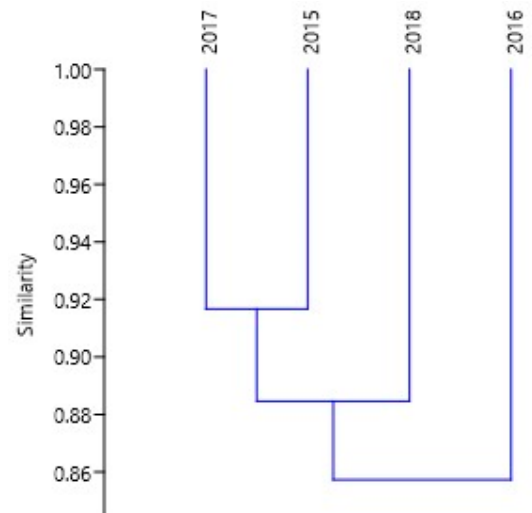
Figure A1. UPGMA (unweighted pair group method with arithmetic mean) dendrogram showing Bray–Curtis similarity of bat communities from each survey/year based on presence/absence of 31 bat species.